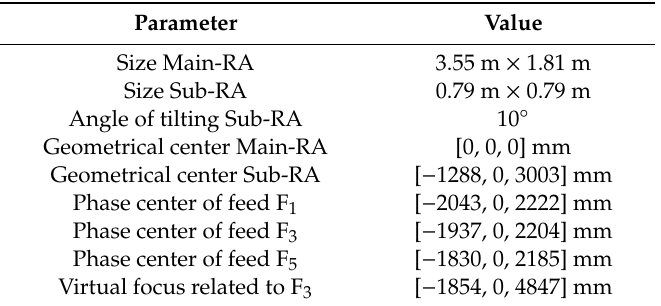
Figure 3. Geometry of the proposed DRAA configuration, formed by an elliptical main RA and a circular sub-reflectarray: ( a ) 3D view, ( b ) lateral view and ( c ) front view. Table 1. Geometric parameters of the DRAA configuration.